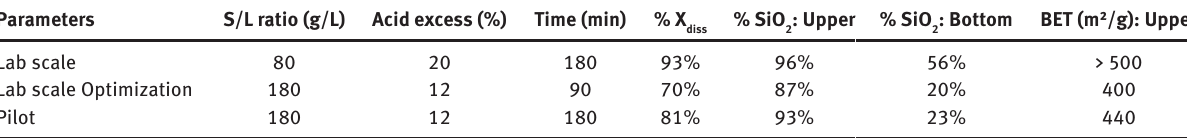
Table 1: Operating conditions and dissolution yield (X